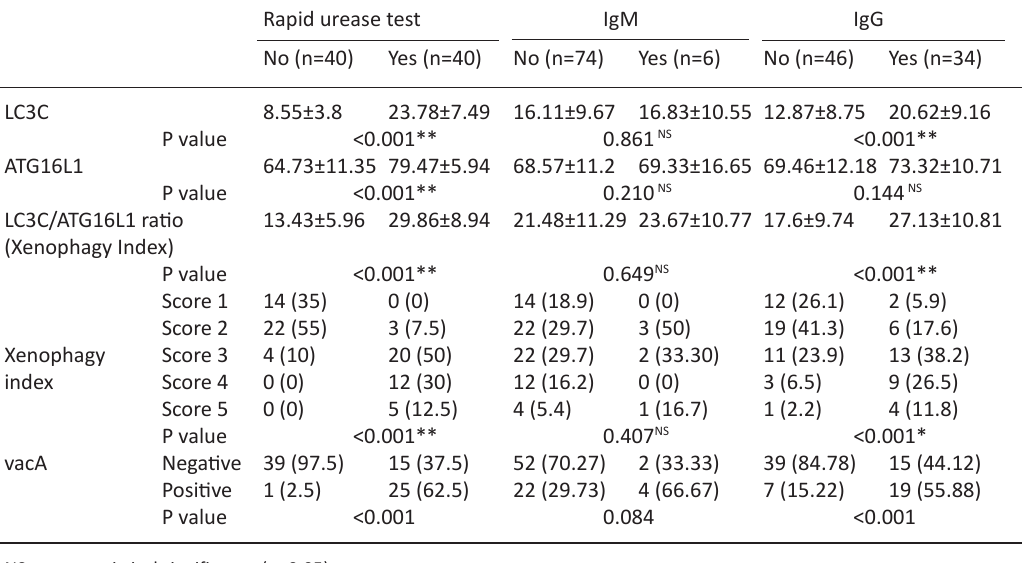
Table 2. Immunohistochemical evaluation of autophagy related proteins and xenophagy